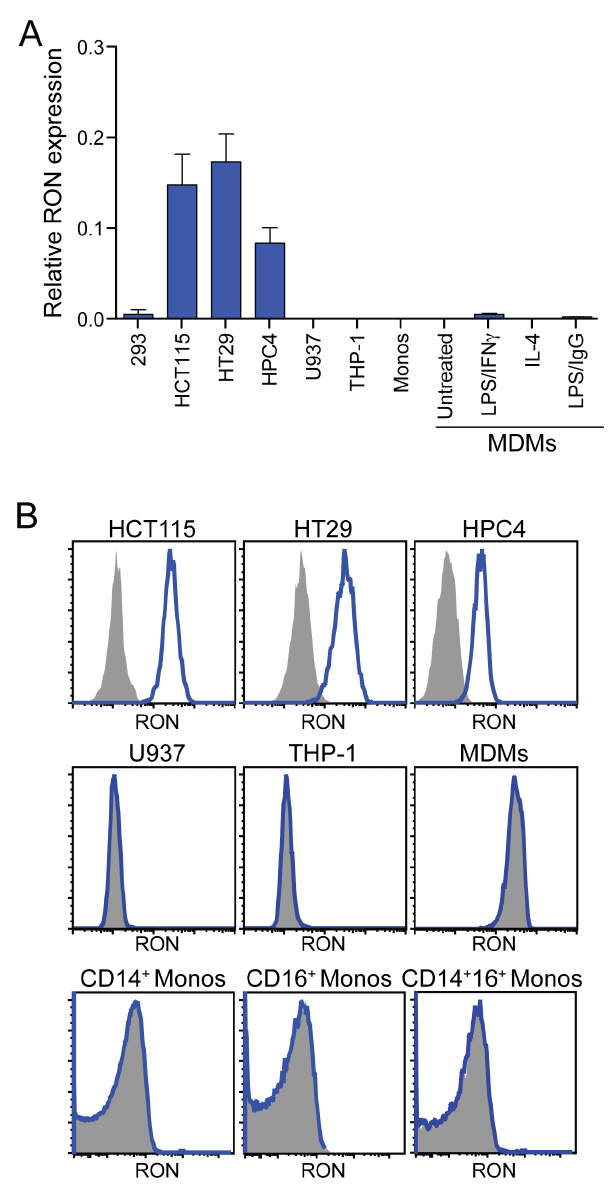
Figure 2. RON is preferentially expressed by human epithelial cells. (A) Quantitative RT-PCR survey of RON expression in human cell lines and primary cells. Columns 1: HEK293 control, columns 2–4: epithelial cell lines, columns 5–6: monocytic cell lines, column 7: human CD14 + monocytes (monos), columns 8–11: monocyte-derived macro- phages (MDMs) left untreated or treated with the indicated stimuli. Data in columns 1-7 are the mean + / 2 SD of three independent samples and columns 8–11 are the mean of two donors. (B) Analysis of single-cell suspensions for RON expression by flow cytometry. Cells were stained with a monoclonal antibody specific for human RON (blue histogram) or an isotype control antibody (shaded histogram). MDMs were gated as CD14 + CD33 +